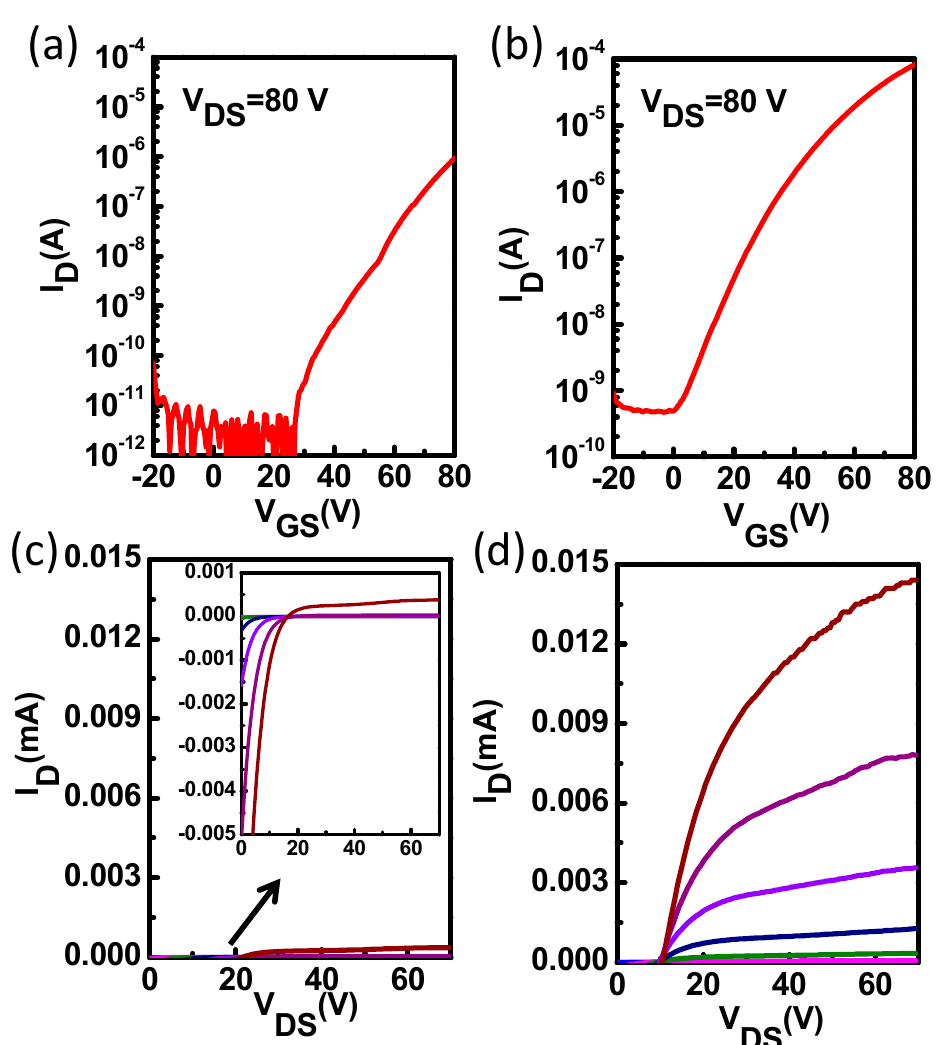
Figure 6. Transfer and output characteristics of the pristine ZnO TFTs ( a , c ) and the ZnO TFTs with PCBA interfacial modification layers ( b , d ) with Ag electrode. Table 2. The electrical characteristics of the pristine ZnO TFTs and the ZnO TFTs with PCBA interfacial modification layers with Ag electrode.